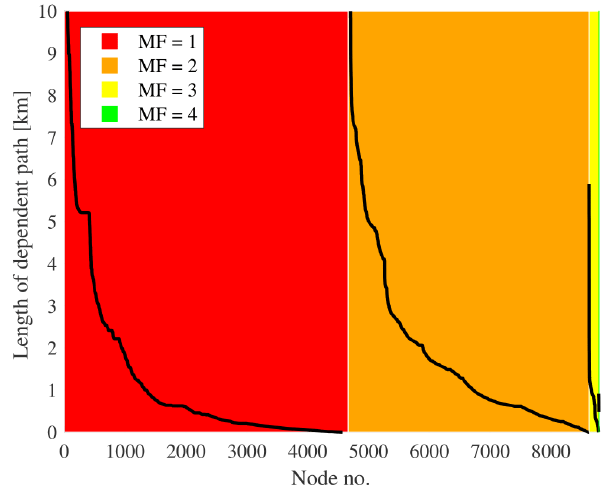
Figure 12. Relation between MF and the length of path limiting the MF value for each node in Trondheim’s